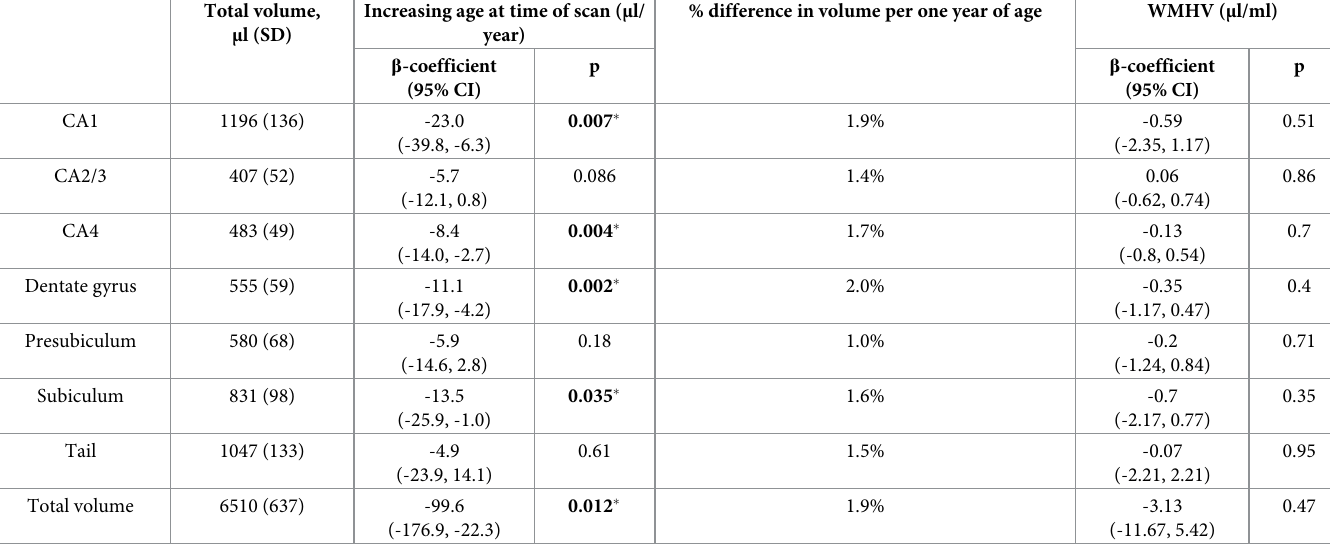
Table 3. Independent influence of age at time of scan and WMHV on individual hippocampal subfield volumes in cognitively normal Insight-46 participants (n = 408) using linear regression models with robust standard errors (co- variates = β -amyloid status, sex and TIV). Unstandardised β -coefficient for age